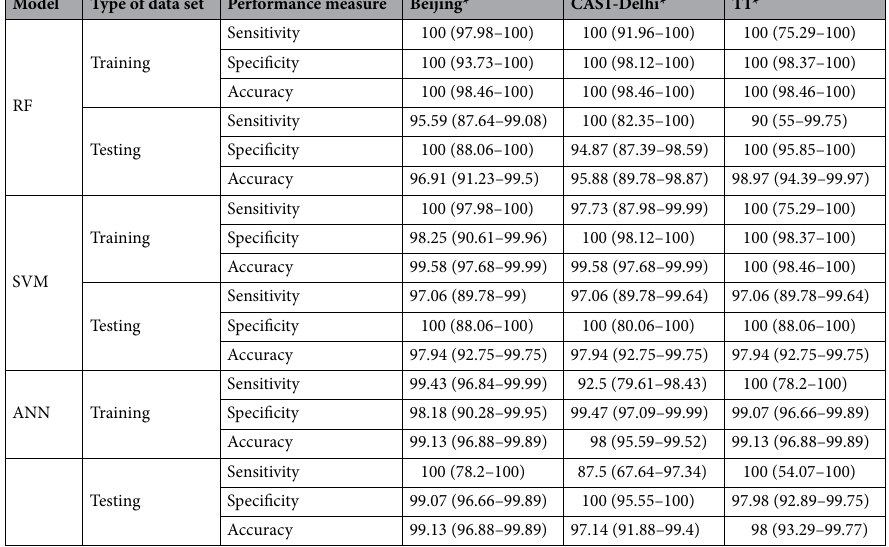
Table 7. Showing performance measure, i.e. (accuracy, sensitivity and specificity) of random forest (RF)/ support vector machine (SVM)/artificial neural network (ANN) analysis. Based on k-fold cross-validation. The training data set is based on 70% of MTBC isolates from Sikkim selected randomly and testing data set is remaining 30% of MTBC isolates from Sikkim which were not used for model training. *The values are in % and 95% confidence intervals are given in parenthesis for SVM/ANN.